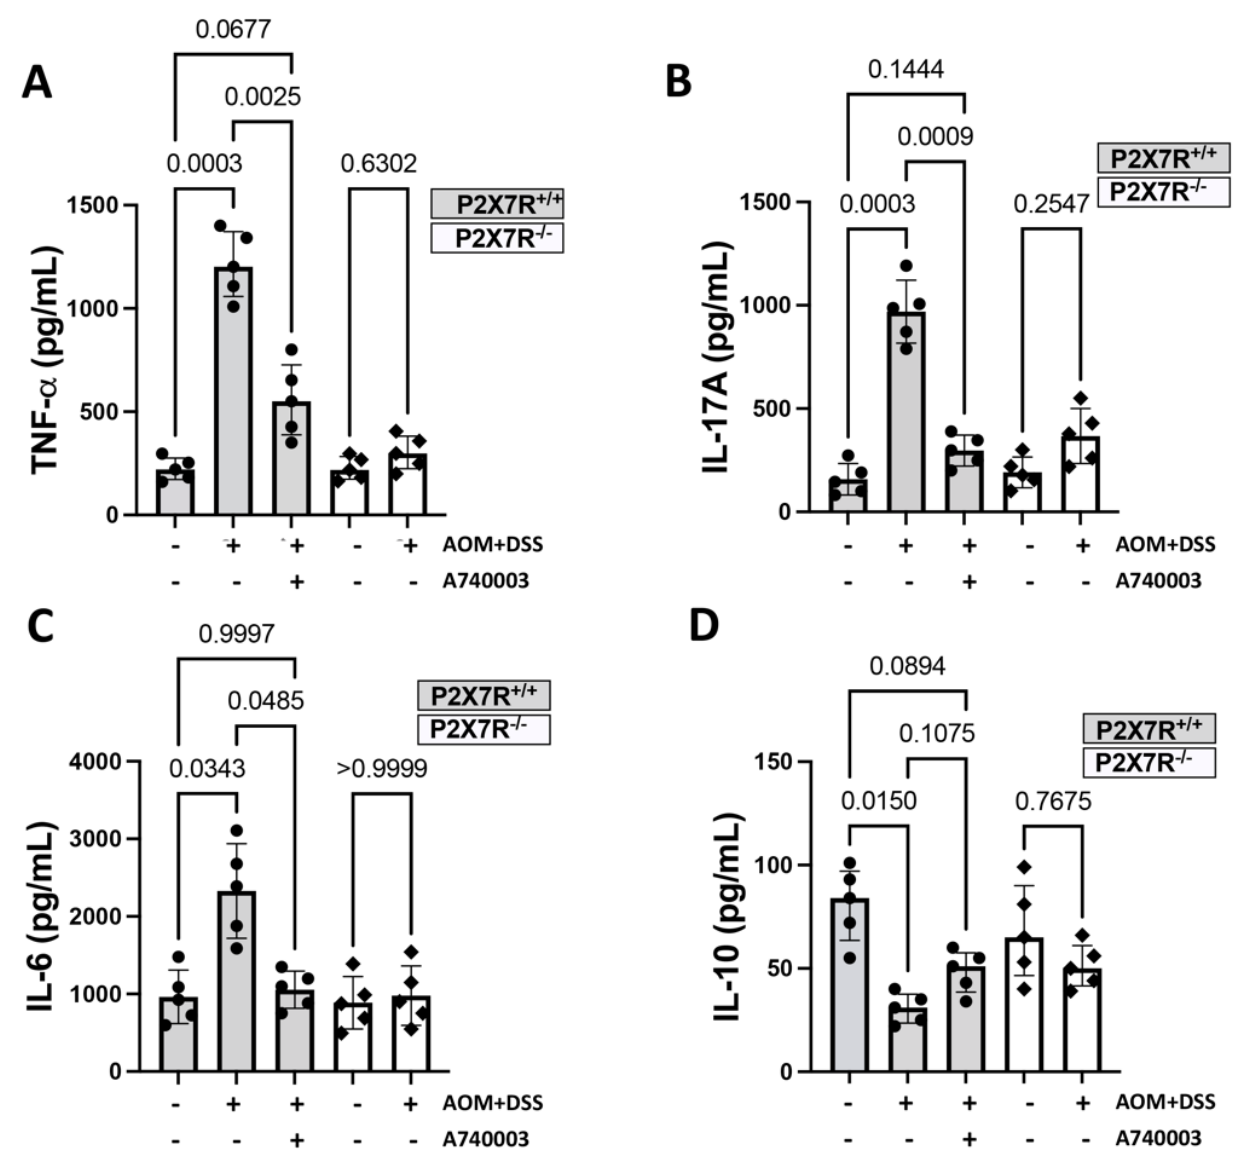
Figure 4. P2X7R blockade modulates proinflammatory cytokine production in colon explants from the AOM/DSS-treated mice. Supernatants from colon explants cultured for 24 h at 37 °C with 5% CO 2 were used to measure the concentrations of cytokines by CBA. The P2X7R − / − and P2X7R +/+ mice treated with the P2X7R antagonist A740003 developed significantly lower concentrations of TNF-alpha ( A ), IL-17A ( B ), and IL-6 ( C ) and higher concentrations of IL-10 than the P2X7R +/+ controls ( D ). The results are expressed as pg/mL. Values are medians with interquartile ranges of three independent experiments, with 4–5 animals per group. Significant values are presented. The analysis was performed by Brown-Forsythe and Welch ANOVA tests, in which multiple comparisons were carried out using Dunnett’s T3 test. Significant values are presented.